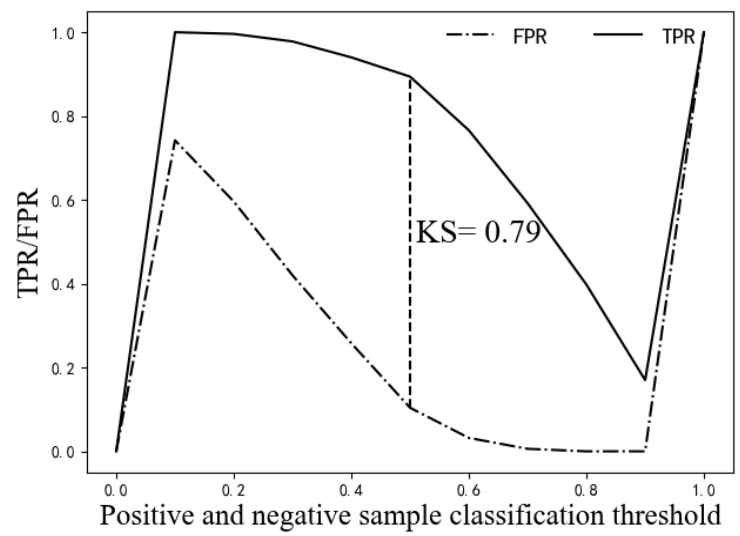
Figure 9. The KS curve of AdaB-GA-SVM.